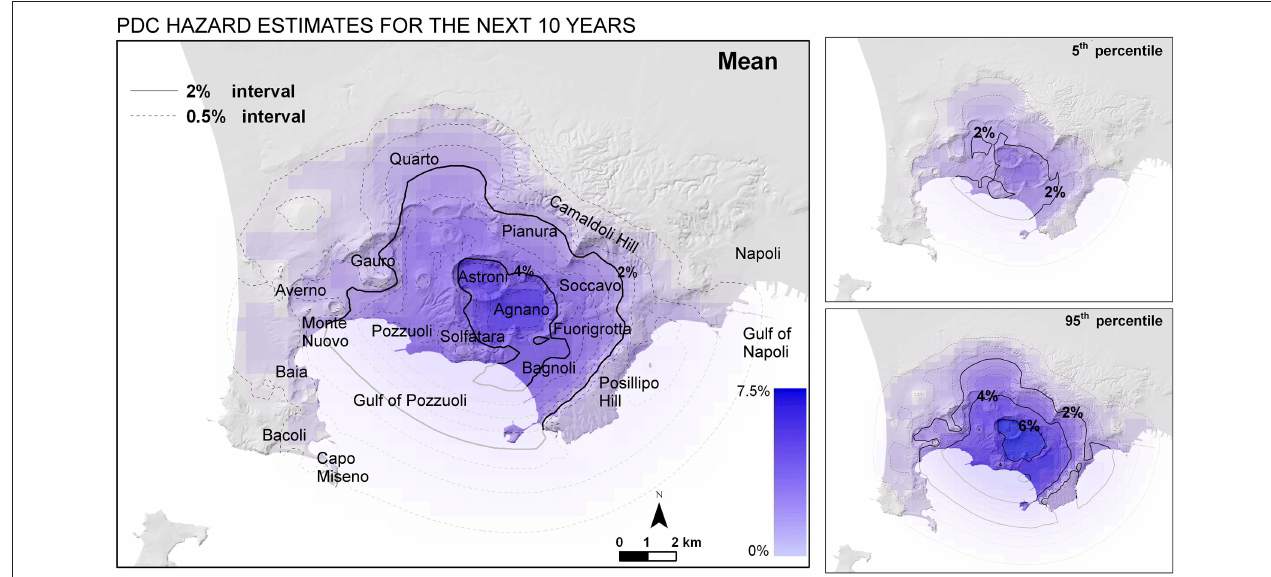
FIGURE 7 | Temporal PDC invasion hazard map based on the vent opening map and the areal size distributions displayed in Figure 3 , and temporal estimates assuming that in A.D. 1538 the volcano entered a new eruptive epoch. Contours and colors indicate the mean percentage probability of PDC invasion in the next 10 years—this excludes the possibility of a sequence of multiple events in this time period. In the small boxes are included the 5th (top) and 95th (bottom) uncertainty bounds of the PDC invasion probability.